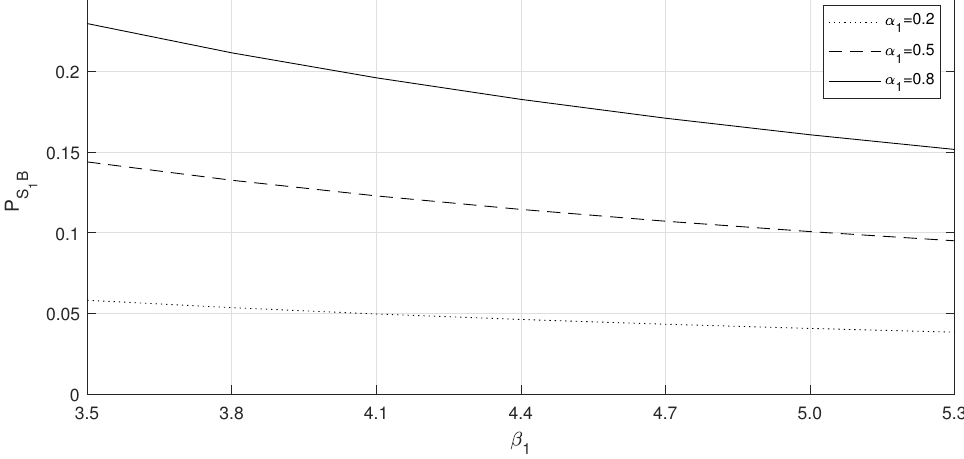
Figure 4. Probability that Server-1 is busy on α 1 vs. β 1 .